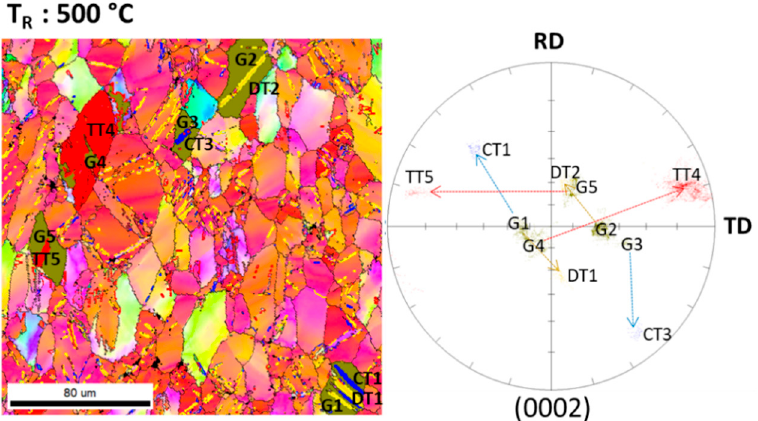
Figure 7. Twin orientations for an AZ31 sheet rolled at 500 °C. Green: parent grains (G1-G5); red: tension twins (TT4, TT5); blue: compression twins (CT1, CT3); yellow: double twins (DT1, DT2).